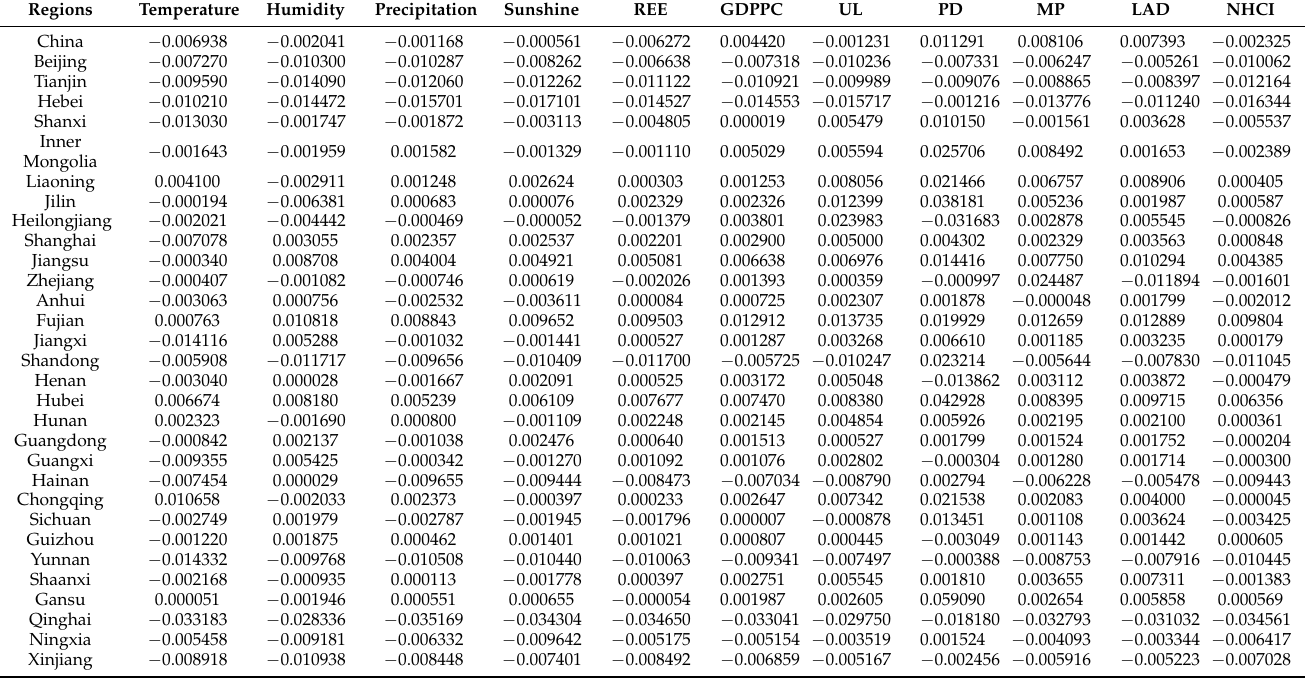
Table 7. How NOH change when each of variables increases by 1% as X × (1 +